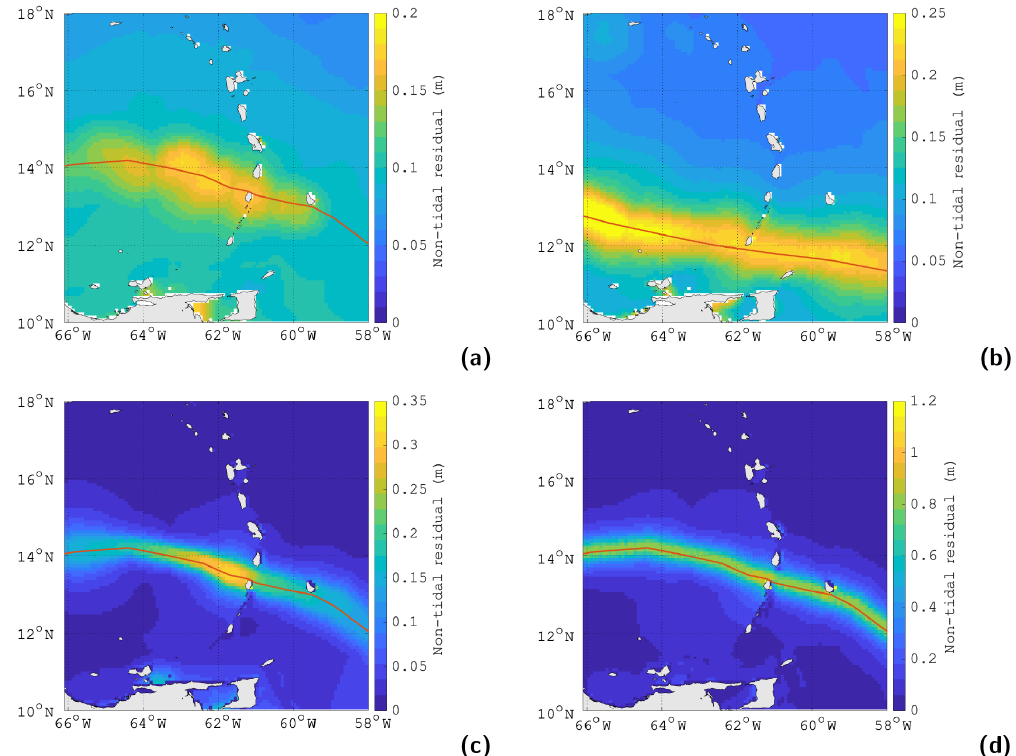
Figure 9. Maximum non-tidal residual envelopes for four model runs: (a) ERA5-forced Hurricane Tomas, (b) ERA5-forced Hurricane Ivan, (c) Holland-forced Hurricane Tomas and (d) enhanced Tomas case